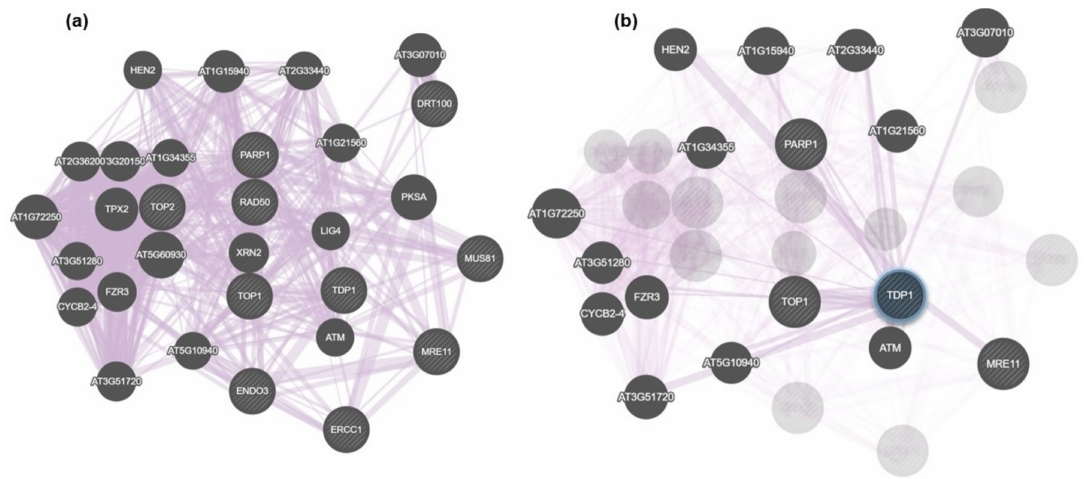
Figure 4. Putative interactive functional association network in Arabidopsis thaliana , as evidenced by GeneMANIA. ( a ) Overall connections at the level of the whole generated network. ( b ) Accessions co-expressed with